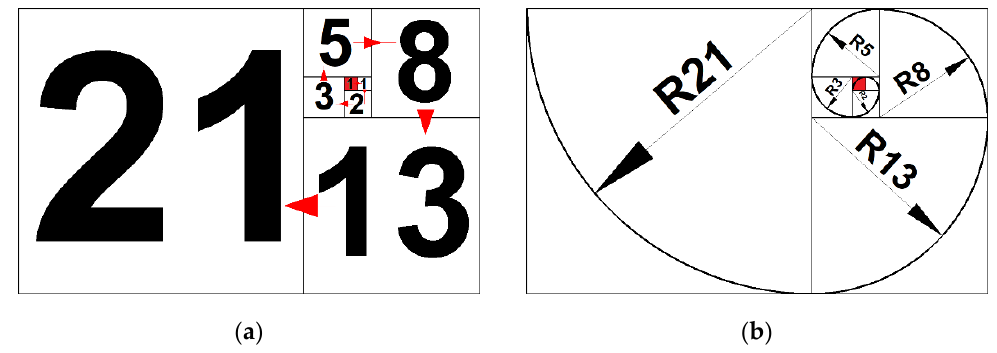
Figure 1. Fibonacci’s spiral; ( a ) distribution of the squares; ( b ) spiral with rations. This work proposes a 200 mm height rotor based on two Fibonacci spirals corre- sponding to the consecutive terms 34 and 55 of the sequence. Two support endplates have been incorporated. These dimensions have been chosen according to the size of the wind tunnel, 400 × 400 mm, used for the experimental setup. The goal was to obtain as much clarity as possible in the comparison. The higher the rotors are, the clearer the contrast is, but the accuracy is reduced due to the blockage effect [28]. The position of both these arcs relative to the rotating axis leads to two different configurations, Figure 2a,b.